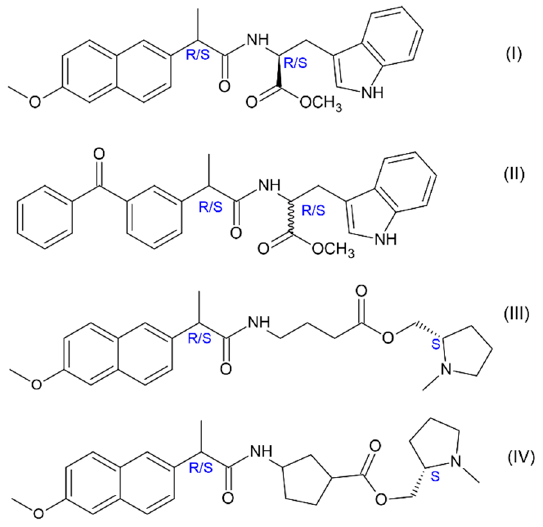
Figure 2. Structures of the model linked systems—dyads (I-IV).